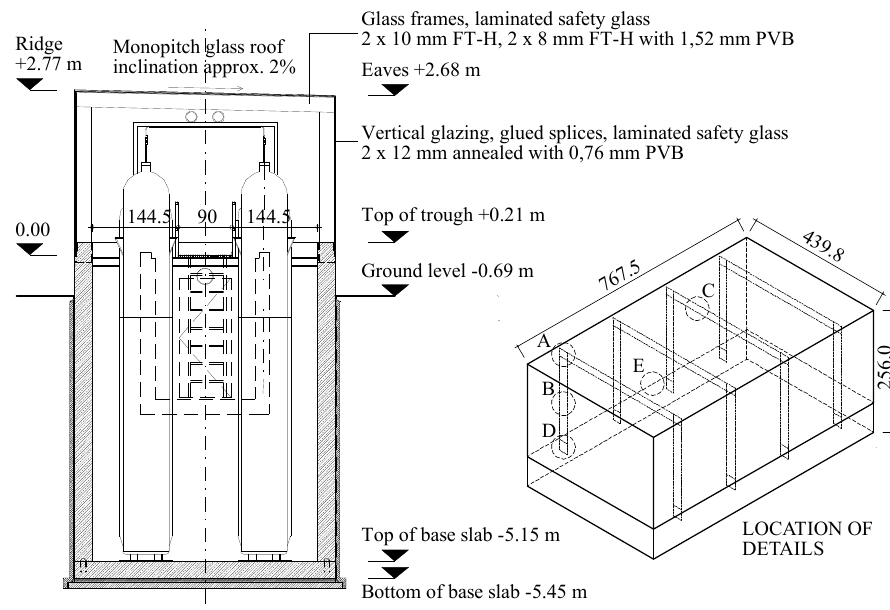
Figure 1: Fully glazed enclosure, transverse section (architects: Blum und Schultze Architekten, Dresden). The frame members are made from four-ply laminated safety glass. Each ply is fully tempered and heat-soaked. At the corners the outer plies of the posts overlap with the inner plies of the rails to form what woodworkers would call a “corner bridle